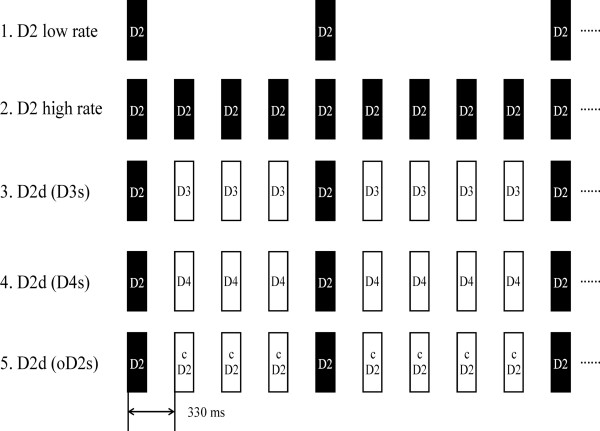
Stimulus paradigm. 1. Low rate (mean ISI; 2s) D2 stimulation (black bars) alone. 2. High rate (mean ISI: 0.33s) D2 stimulation alone. 3. Ipsilateral D3; 4. ipsilateral D4; 5. contralateral D2 as the standard stimulus respectively (white bars), with D2 as the deviant stimulus (black bars) in the digit mismatch paradigm. RD 3, 4 and LD 2 were used as standards with RD2 as deviants; LD 3, 4 and RD2 were used as standards with LD2 as deviants.